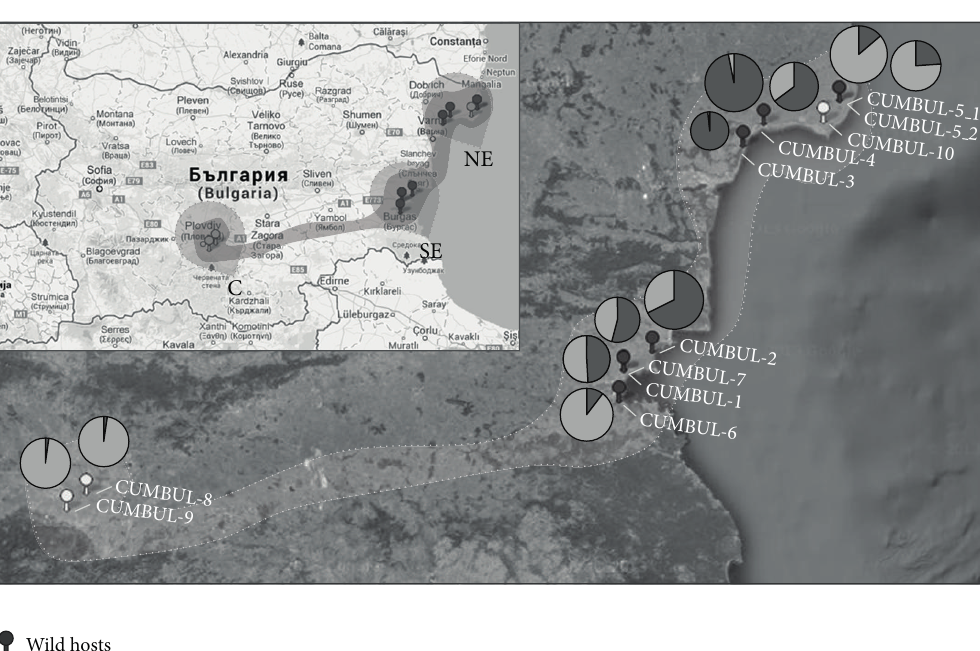
Figure 1: Geographical distribution of Orobanche cumana Bulgarian populations collected on wild and cultivated hosts (left side of the figure) and map of mean membership probabilities per population as obtained using Bayesian clustering analysis resulting from STRUCTURE at 𝐾 = 2 (right side of the figure). Pie size is proportional to the size of each population.